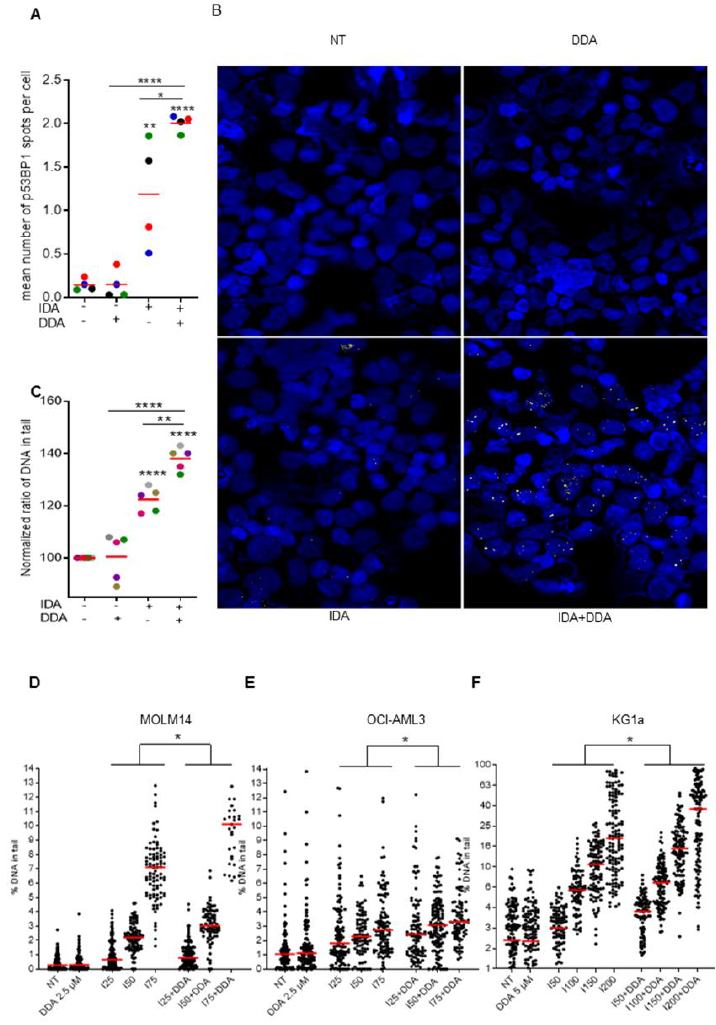
Figure 3. DDA potentiates DNA damage due to idarubicin ( A ) Sample of AML patients ( n = 4) were treated with DDA (2.5 µ M) or IDA (10 nM) or both DDA and IDA (2.5 / 10 nM) or vehicle for 15 h and then analyzed in immunofluorescence. Data were represented as mean of p53BP1 spots per nuclei. ( B ) Representative images of primary AML cells. Nuclei are represented in blue and p53BP1 appear in red. ( C ) Sample of AML patients ( n = 5) were treated with DDA (2.5 µ M) or IDA (10 nM) or both DDA and IDA (2.5 / 10 nM) or vehicle for 15 h and then a standardize comet assay was performed. Data were represented as mean % of DNA in tail in cells relative to the vehicle-treated cells. ( D – F ) AML cell lines (MOLM14, OCI-AML3 and KG1a) were treated with vehicle, DDA (2.5 µ M or 5 µ M) or IDA at increase concentration or both DDA and IDA for 15 h and then a standardized comet assay was performed. Data were represented as % mean of DNA in tail in cells. Spots represent the % of DNA in tail in one single cell of 3 independent experiments. * p < 0.05, ** p < 0.01 and *** p < 0.001, **** p <